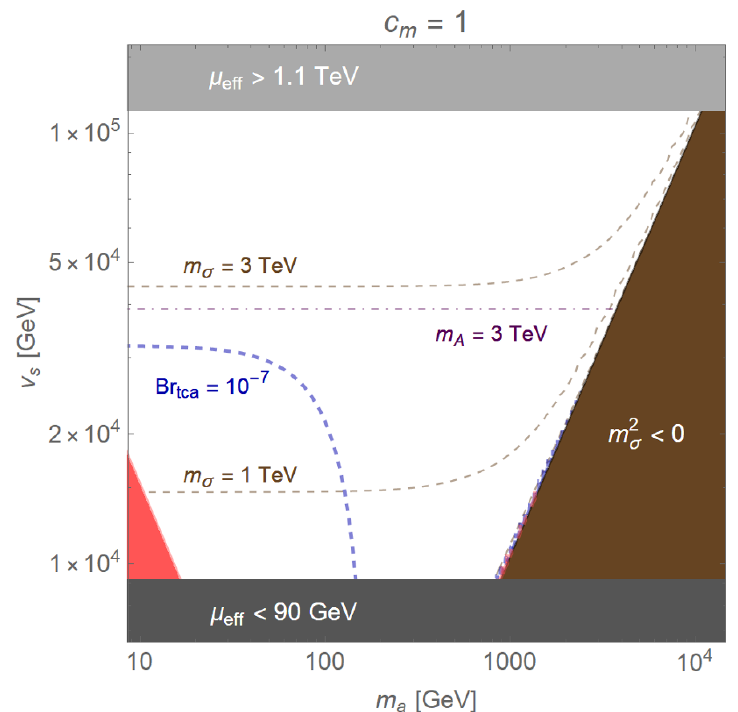
Figure 3 . Allowed region in the ( m a , v s ) [GeV] plane for c m = 1 in the Higgsino LSP case. In the wino LSP case, a larger VEV v s is allowed. White region is consistent with observations. j R (cid:15) j > 0 : 1 in the red region. The blue lines show the branching fraction of the (cid:13)avor changing top K decay t ! ca is at 10 (cid:0) 7 . The other dashed lines show masses of the CP-even (cid:13)avon and CP-odd Higgs